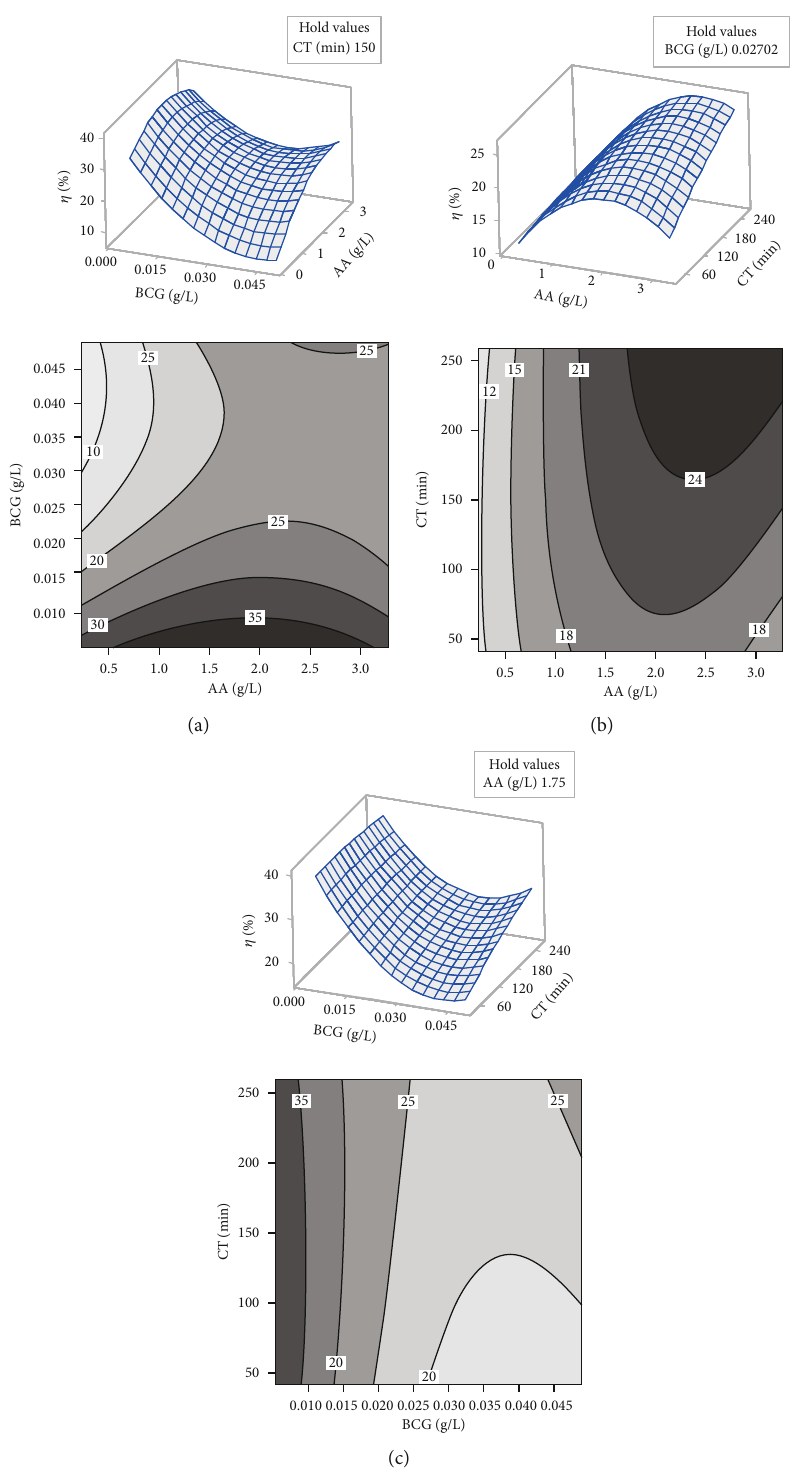
Figure 5: Surface and contour plots: (a) e ffi ciency vs. BCG (g/L) and AA (g/L) at CT = 150 min ; (b) e ffi ciency vs. AA (g/L) and CT (min) at BCG = 0 : 02702g/L ; (c) e ffi ciency vs. BCG (g/L) and CT (min) at AA = 1 : 75g/L